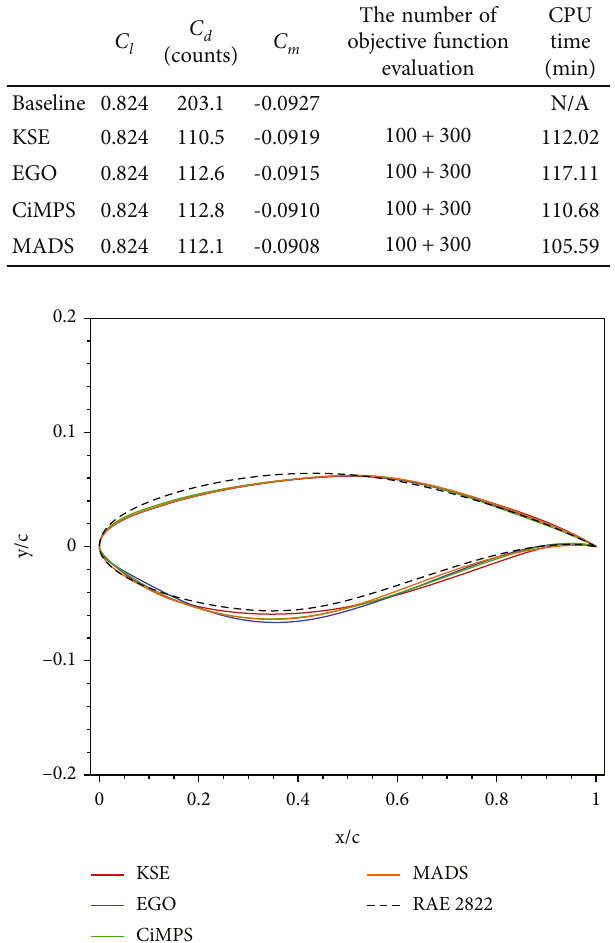
Figure 17: The comparison of optimized airfoil shape. algorithm ’ s performance, three other global optimization